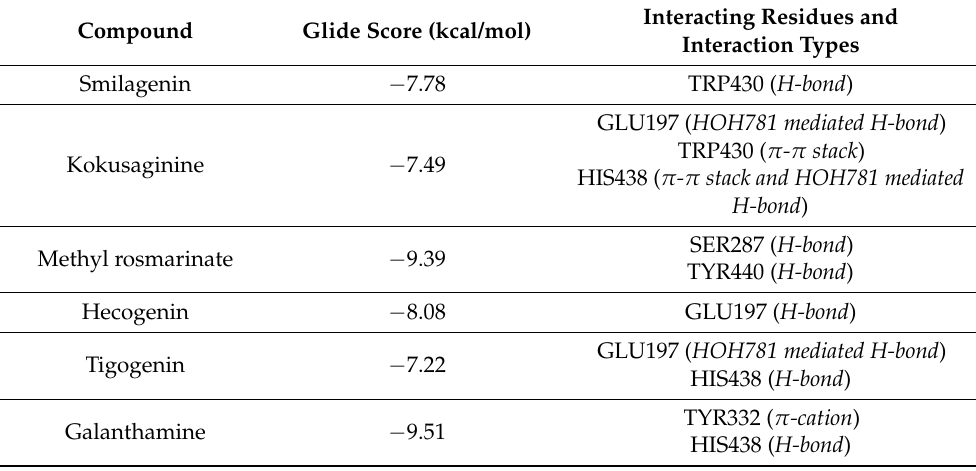
Table 3. Molecular interactions of the compounds docked with hBChE active site